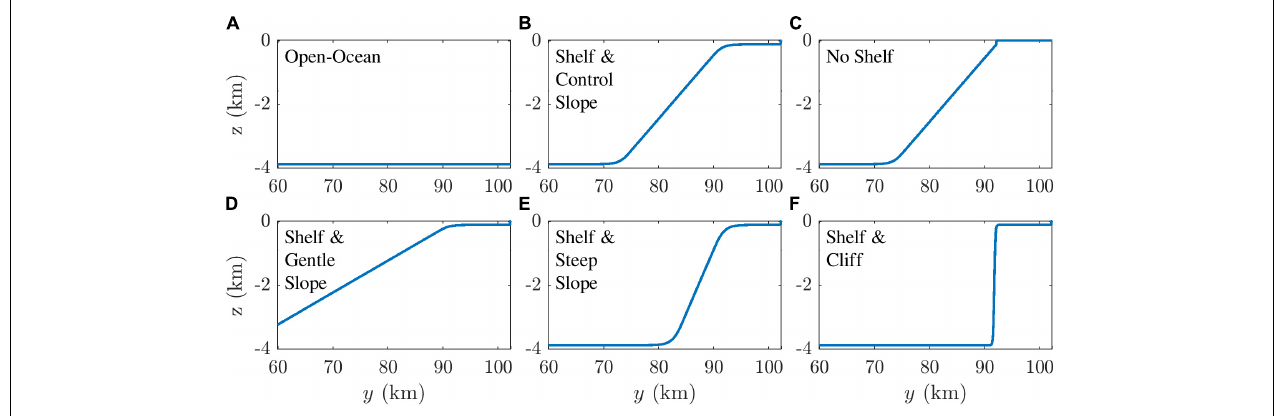
FIGURE 3 | Side view of model topographies: (A) open ocean (OO), (B) shelf and control slope (SCS), (C) no shelf (NS), and shelf with (D) gentle slope (SGS), (E) steep slope (SSS), and (F) cliff (SC). Plots are confined to y ≥ 60